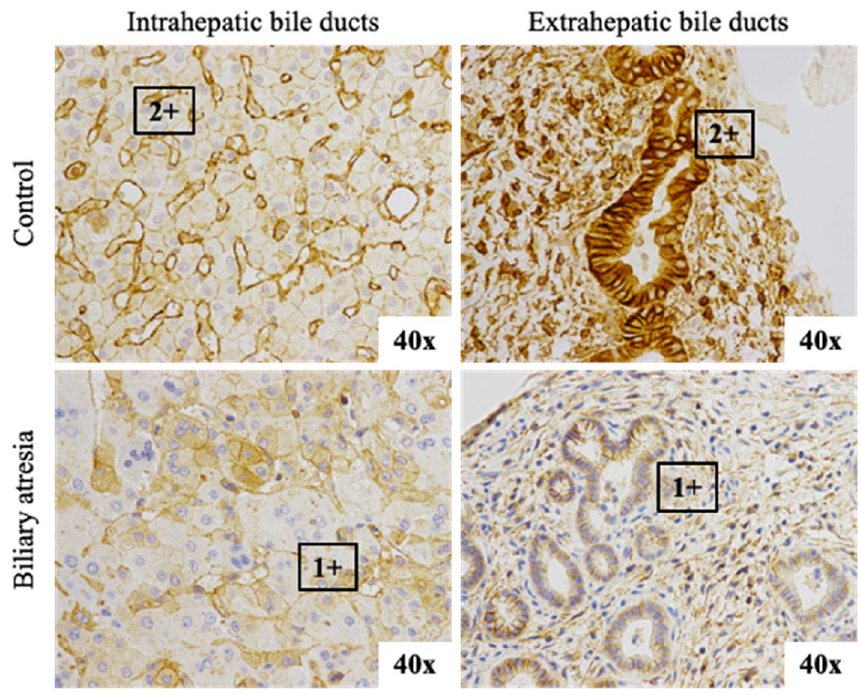
Figure 1. Immunohistochemistry staining of ADD3 proteins in the biliary epithelium showing decreased expression in both areas of the biliary atresia